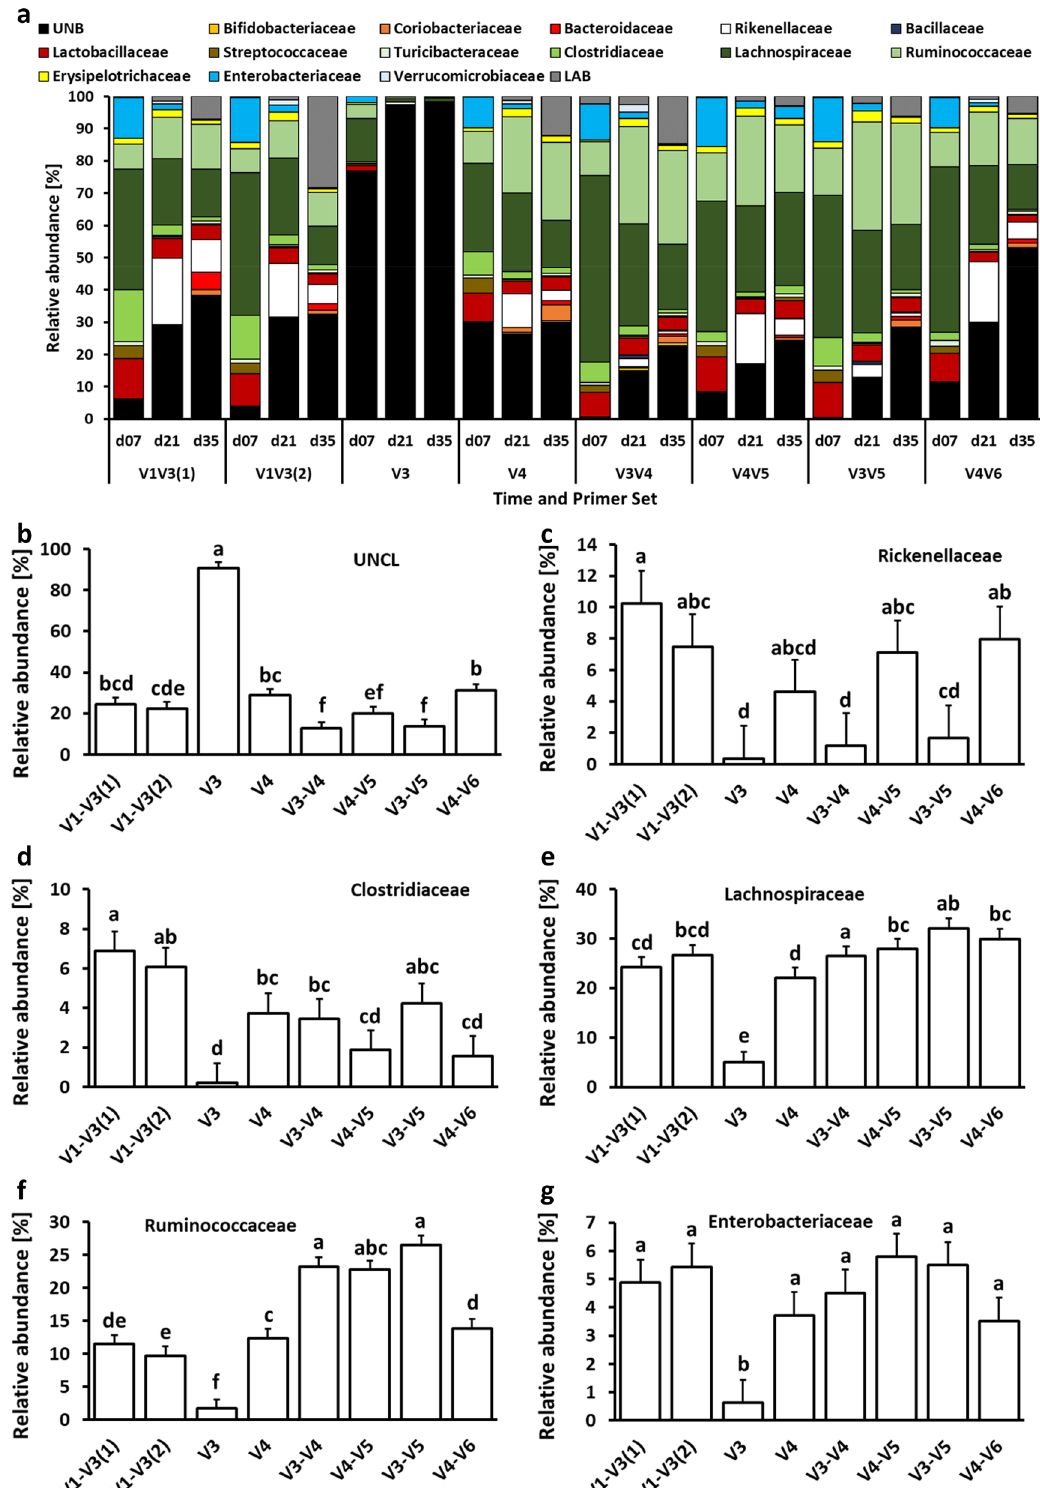
Figure 4. Changes in relative bacterial abundance (%) in chicken cecal content at family level. (a) Taxonomic profile of chicken cecal microbiota. Effect of primer sets on the relative abundance of (b) unclassified bacteria (UNCL), (c) Rikenellaceae , (d) Clostridiaceae , (e) Lachnospiraceae , (f) Ruminococcaceae , and (g) Enterobacteriaceae . Only significant ( P < 0.05) data are shown and only first 6 families with the highest abundance are shown. Different letters denote statistically significant ( P < 0.05) differences between primer